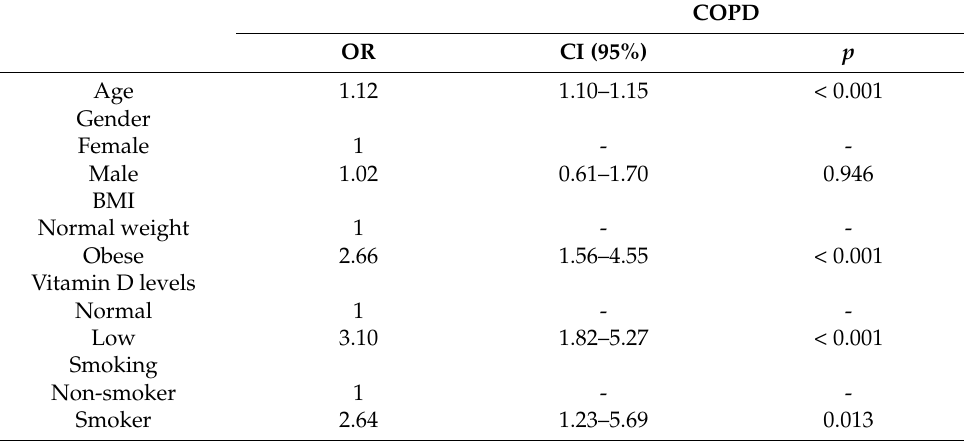
Table 2. Multiple logistic regression analysis with chronic obstructive pulmonary disease. 141